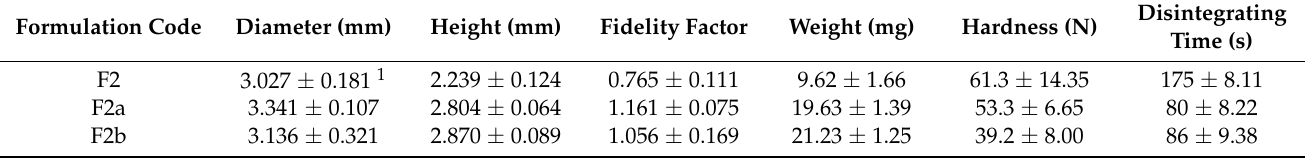
Table 9. Differences in preparation and fabrication via SSE of F2a, F2b and F2.